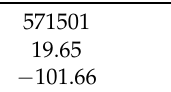
Table 1. Station information.